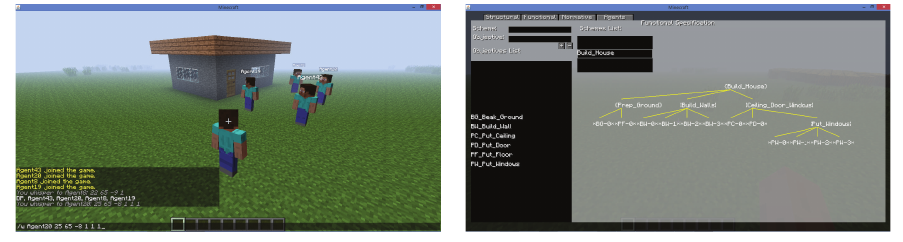
Figure 2: Proof of concept prototype based on Minecraft, JADE, and